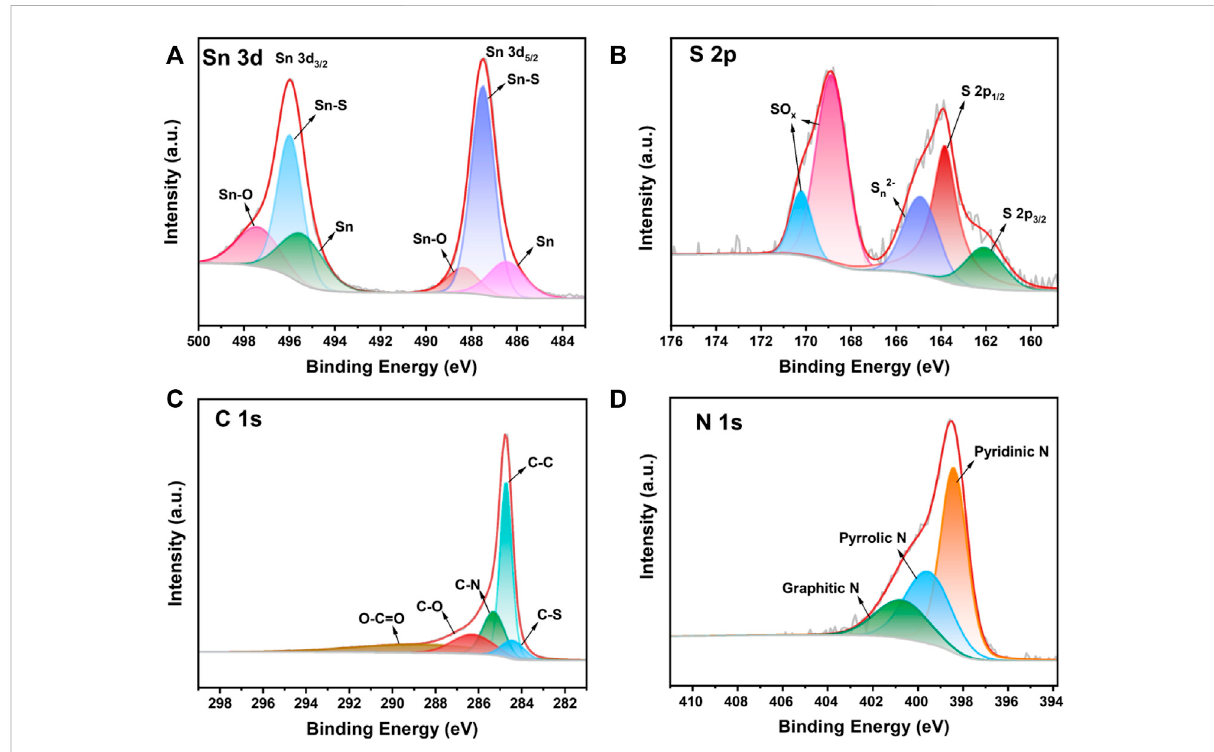
FIGURE 3 High-resolution XPS spectra of the SnS@C/G composite: (A) Sn 3d, (B) S 2p, (C) C1s, and (D) N